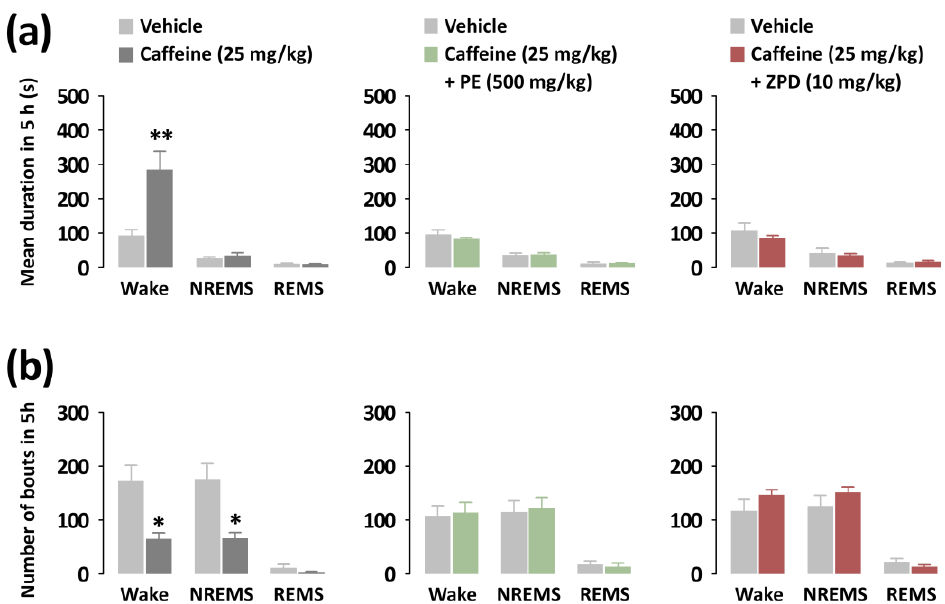
Figure 5. Characteristics of sleep–wake episodes in C57BL/6N mice during the 5 h period after the administration of caffeine alone, caffeine + PE, or caffeine + ZPD. ( a ) Changes in the mean duration of wake, NREMS, and REMS bouts. ( b ) Changes in the total number of Wake, NREMS, and REMS bouts. Each value represents the mean ± SEM ( n = 7 – 8 per group). * p < 0.05, ** p < 0.01, significantly different from the vehicle control (paired Student’s t -test).